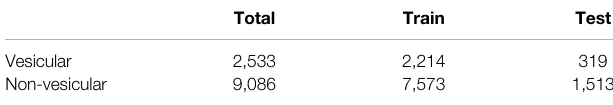
TABLE 1 | Statistics of the dataset in this work. Total